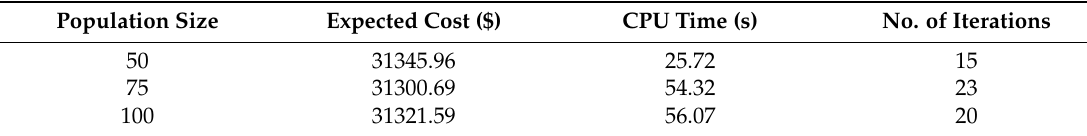
Table 10. Performance of traditional GA considering different population sizes.